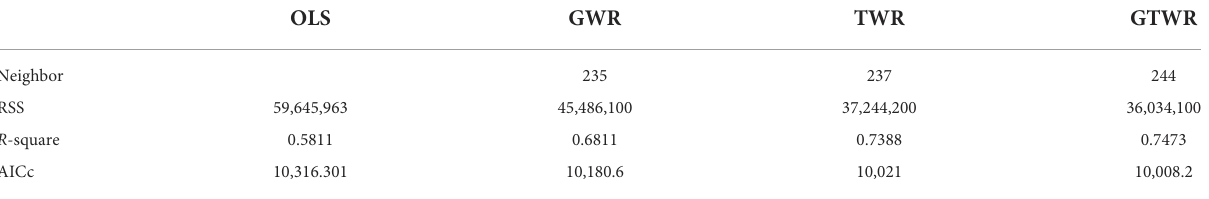
TABLE 5 Performance comparison of four models on the entire data set. OLS GWR